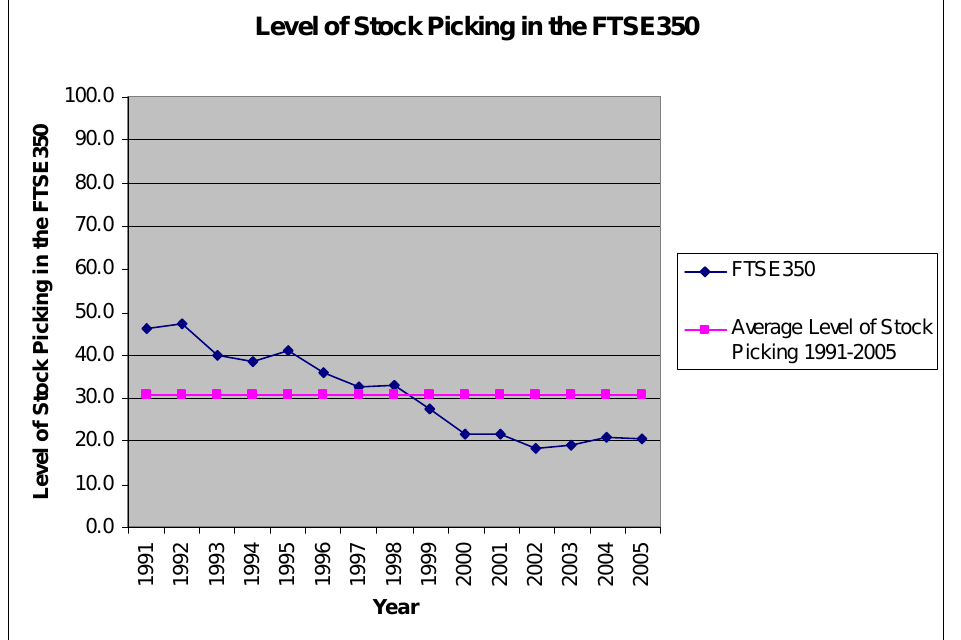
Figure 1: Stock Picking in the FTSE350 1991-2005. Level of Stock Picking in the